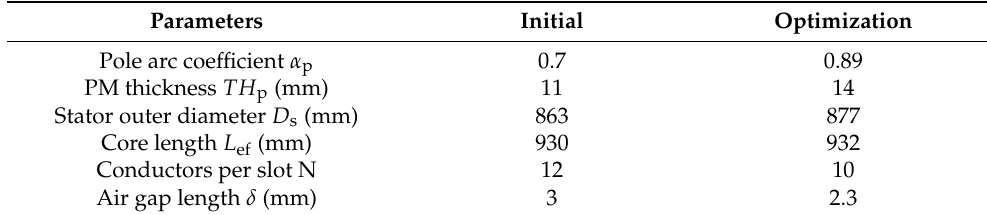
Table 4. Initial and optimized parameters.